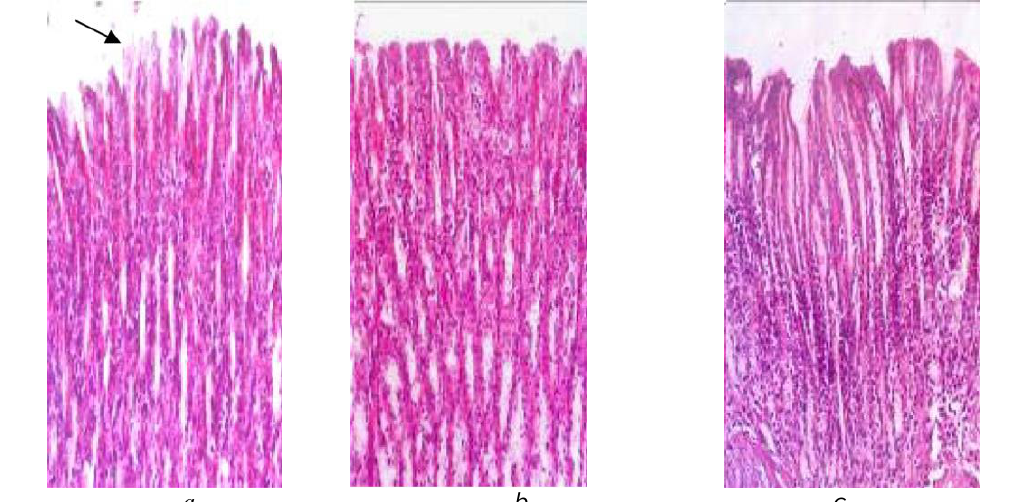
Fig. 6. The stomach of rats, which were introduced alcohol-prednisolone mixture. The distinct depletion of the cyto- plasm of mucous-forming cells of the mucous membrane of the: a – fundal; b – the prepyloric; c – the pyloric parts of the PAS -positive material. PAS-reaction. ×200